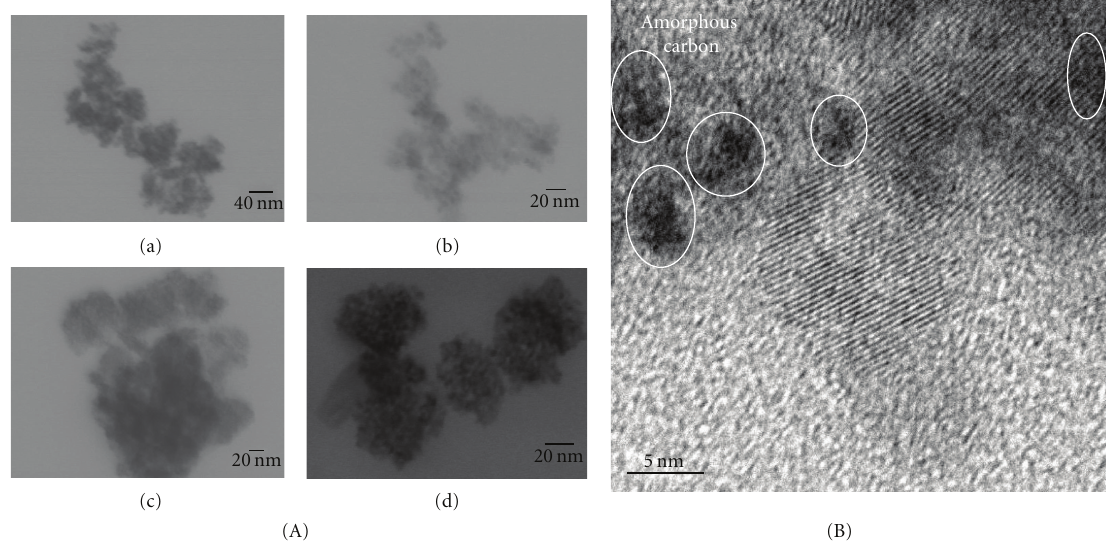
Figure 4: FE-SEM images (A) of UV100 (a), C3/UV100 (b), C6/UV100 (c), and cC6/UV100 (d) and TEM image of cC6/UV100 (B).